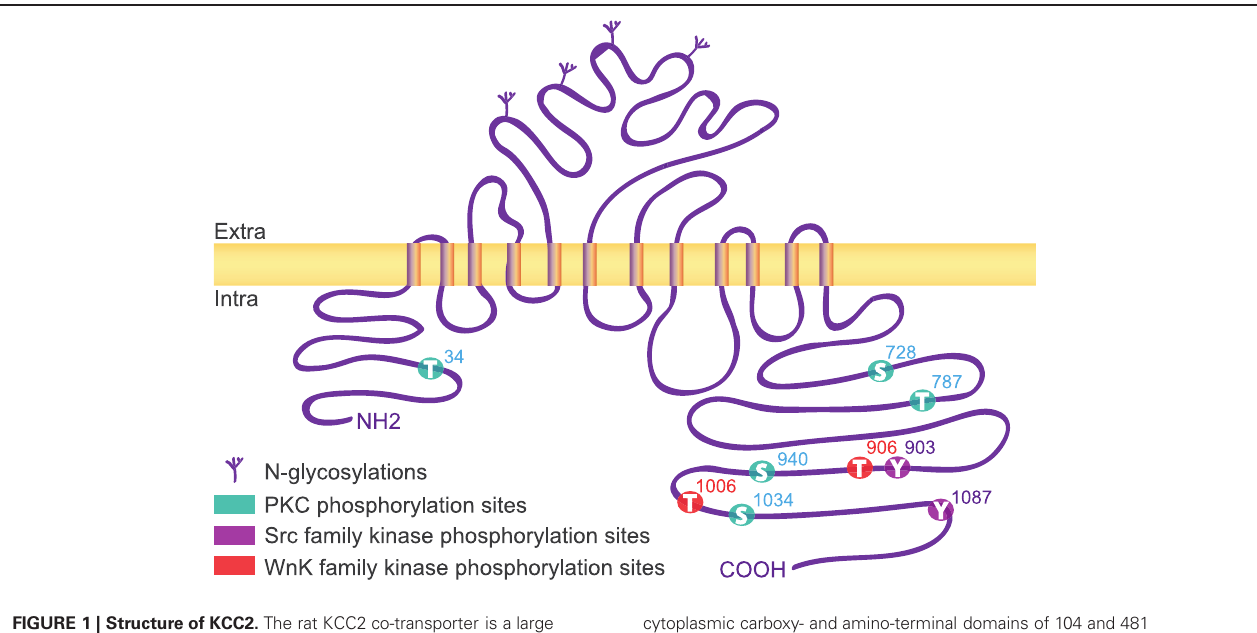
FIGURE 1 | Structure of KCC2. The rat KCC2 co-transporter is a large size ( ∼ 140kDa) protein with a predicted topology of 12 membrane spanning segments, a N-linked glycosylated extracellular domain between transmembrane domains 5 and 6, and is flanked by two